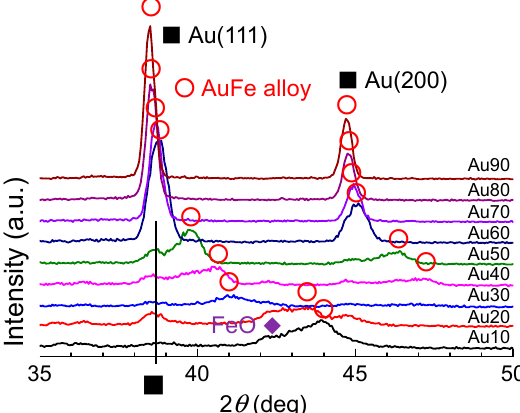
Figure 5. XRD patterns of particles obtained by laser irradiation onto the mixed colloidal solution of Au and Fe 2 O 3 in ethanol. “Au10” denotes Au 10%:Fe 90% in weight.